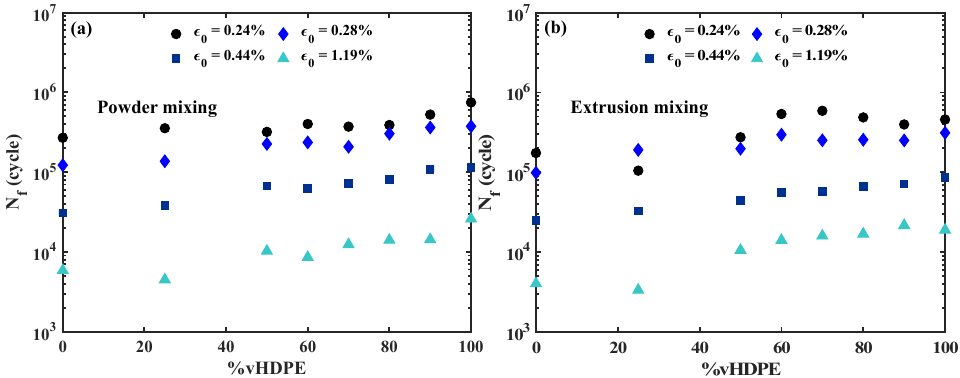
Figure 7. Correlation between the vHDPE content and the fatigue lifetime ( N f ) under different strain amplitudes for both processing methods: ( a ) powder mixing and ( b ) extrusion mixing.